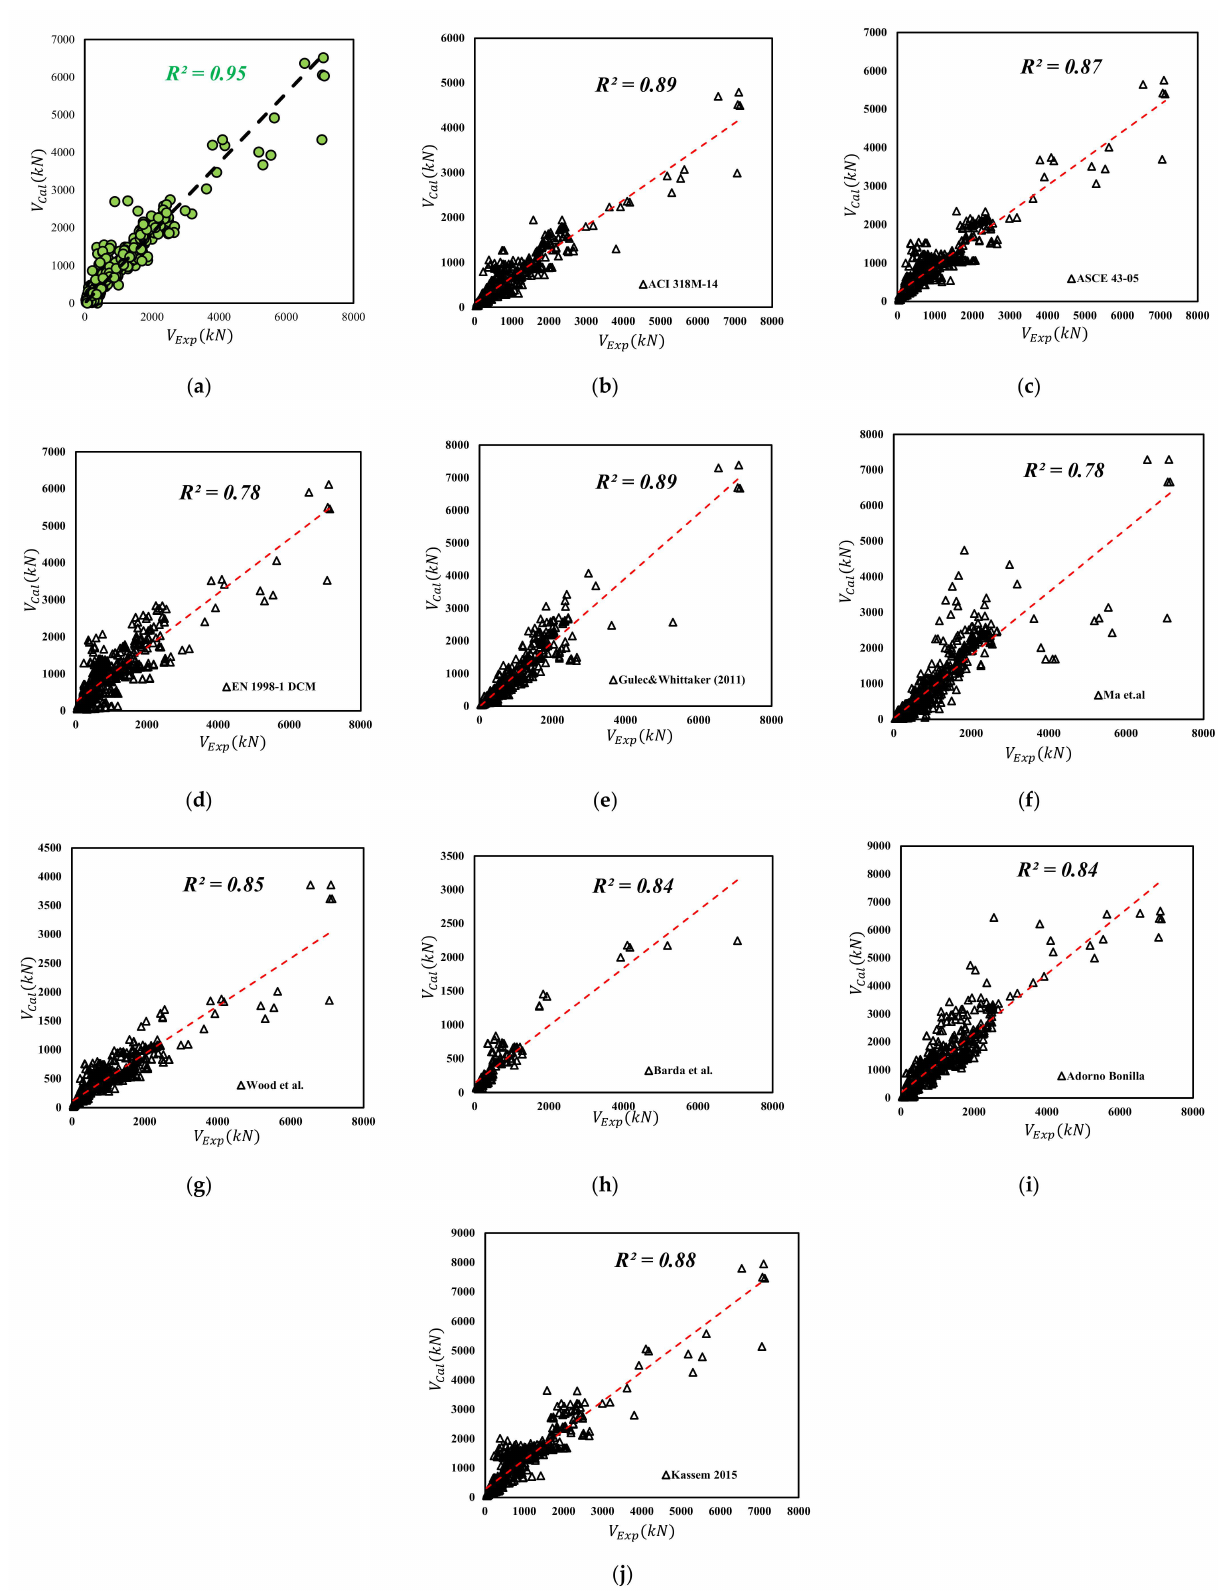
Figure 7. Comparative results of test data and different available methods. ( a ) Proposed Model ( b ) ACI 318M-14 [8], ( c ) ASCE 43-05 [9], ( d ) EN 1998-1 [10], ( e ) Gulec &Whittaker [5], ( f ) Ma, et al. [15], ( g ) Wood, et al. [3], ( h ) Barda, et al. [2], ( i ) Adorno-Bonilla [7], ( j ) Kaseem